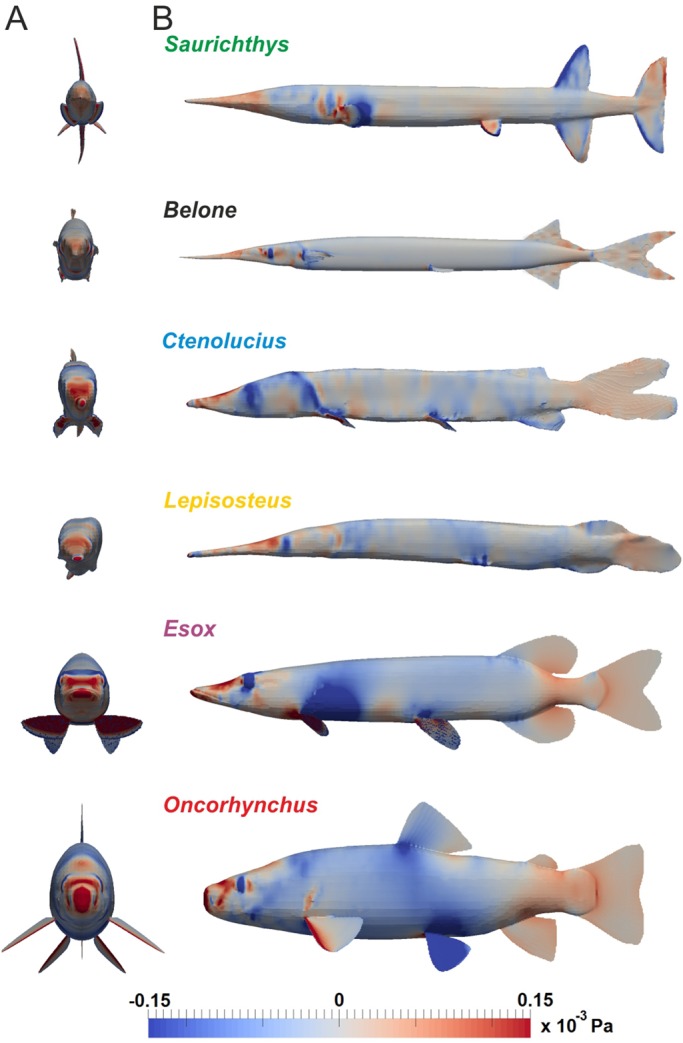
Surface pressures. Distribution of surface pressures (p=ptotal−pdyn) over the fish bodies at ufish=1 ms−1 in anterior view (A) and lateral view (B). Regions of low pressure are coloured in blue, high pressure areas in red.